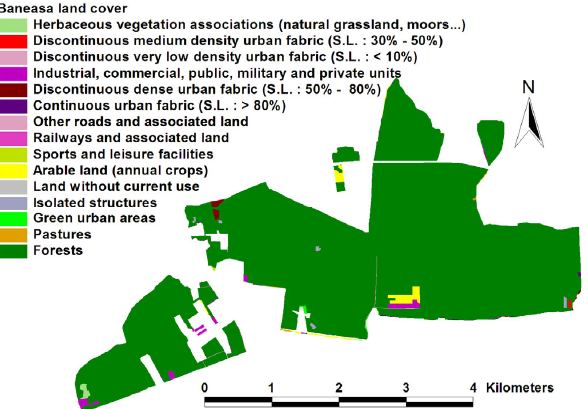
Figure 5. Land cover of B ă neasa Forest based on 2018 Urban Atlas data. As the name of site suggests, the image shows that the dominant land use is represented by forests.